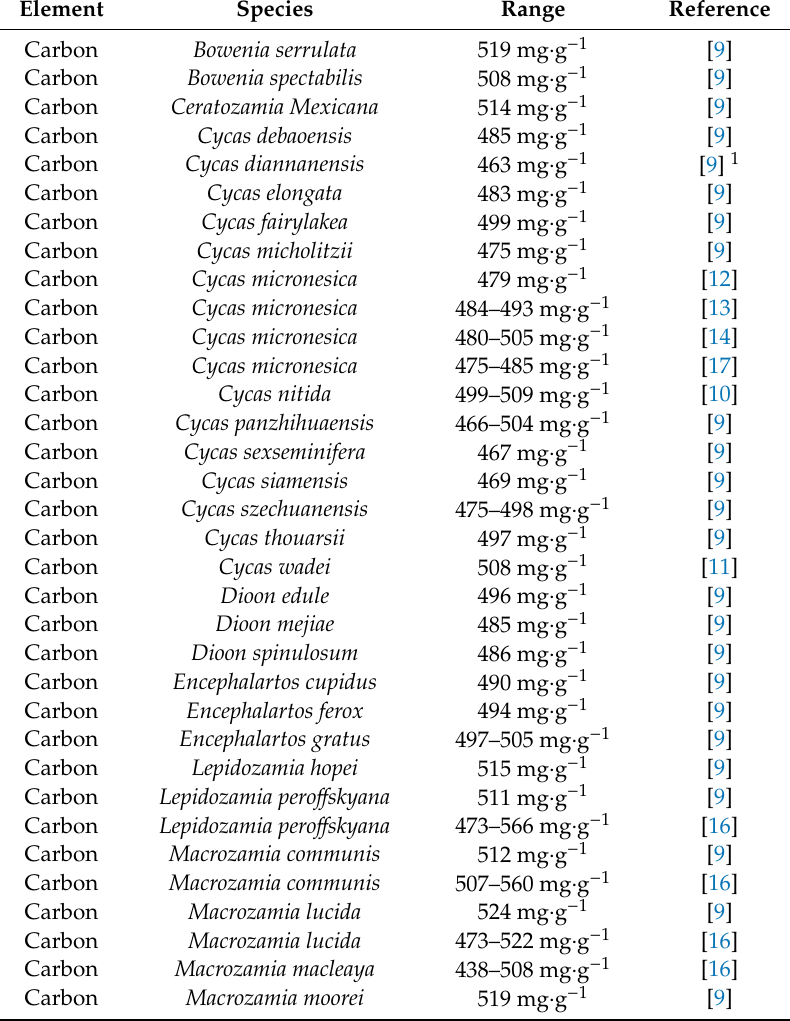
Table A1. Published ranges for green leaf element concentrations of cycad plants. Misspellings of species were corrected if identity was obvious, species that were misspelled were not included if identity was not obvious. Taxonomic synonyms were corrected. Data were estimated for reports displaying data as figures and transformed if data were presented in log